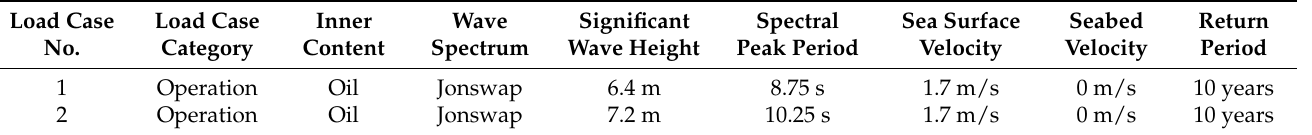
Figure 4. Schematic diagram of the SCR. ( a ) Simulation model of SCR (Positive direction of x-axis is north) and ( b ) SCR static balance structure diagram. Table 2. Load cases for the